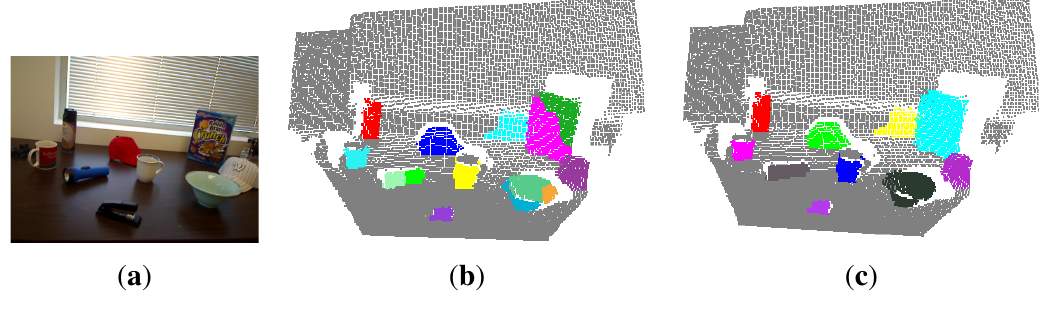
The multi-class labeling result ( b ) for an example input RGB-D image ( a ) (only the RGB image is shown here) after performing the Markov random field (MRF) optimization; ( c ) the final result after performing refinement operations. Different objects are randomly